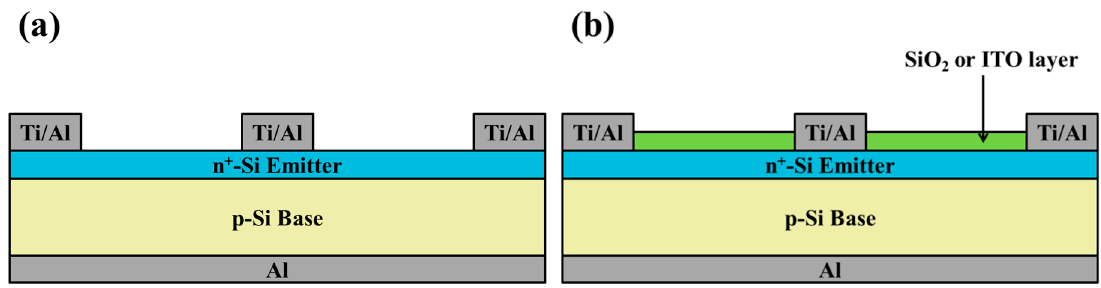
Figure 1. Schematic diagram of ( a ) the bare solar cell, ( b ) cell with SiO 2 (250 nm) or ITO (54 nm) antireflective layer. ITO, indium-tin-oxide.